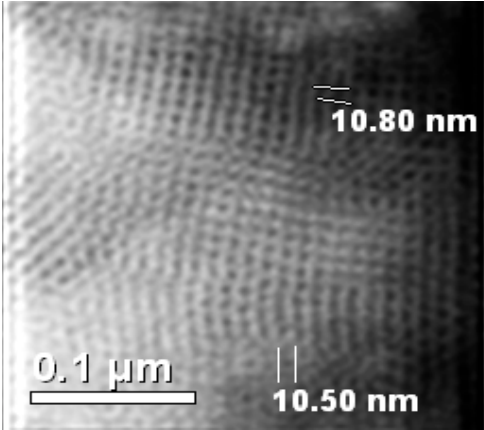
Figure 2. Transmission electron microscopy (TEM) image of the 3.8N/SBA-16 adsorbent showing a well-ordered cubic array of unit cells. Table 1. Some textural properties a of the amine-functionalized SBA-16 adsorbents and their adsorption efficiency for Pb 2+ removal from aqueous solution b.